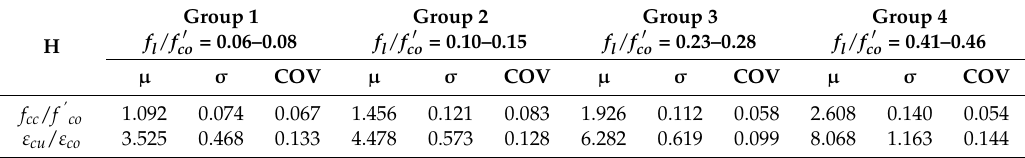
f ′ and ε cu / ε co under different replacement f / co cc